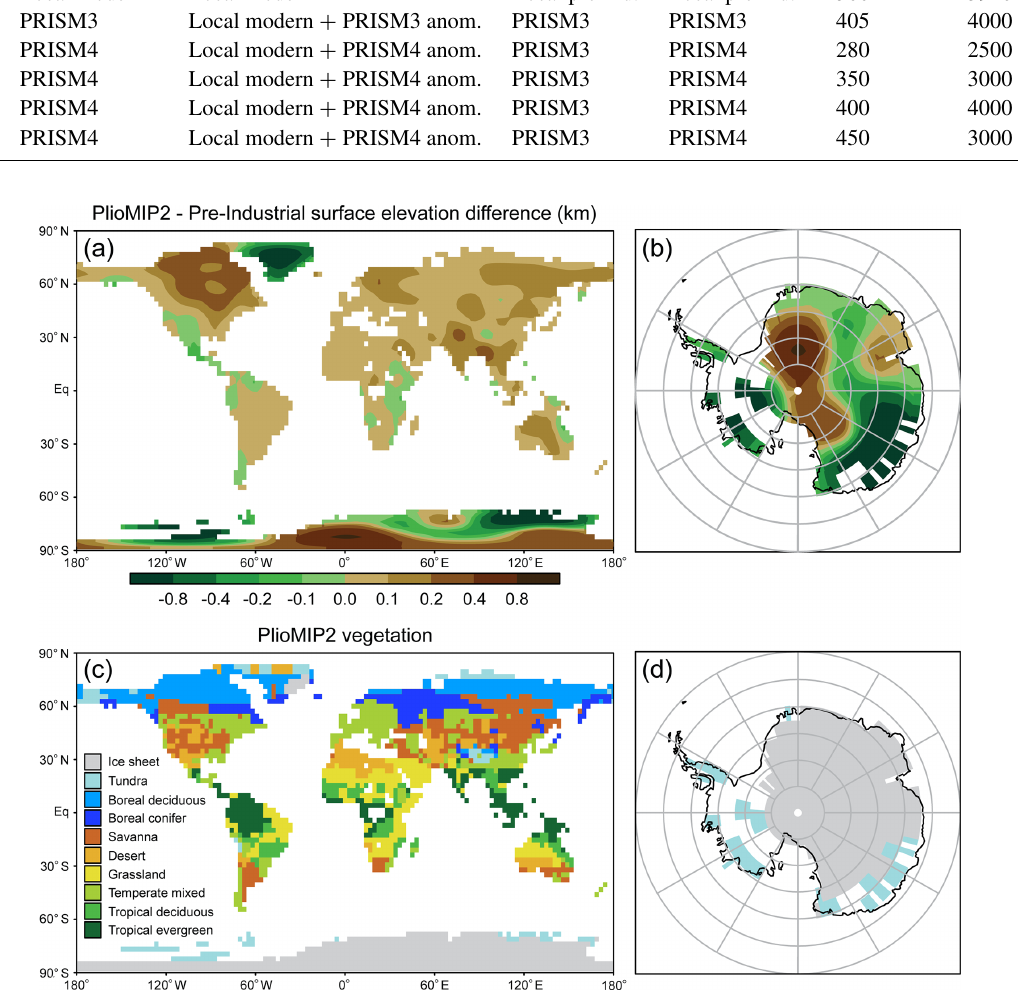
Figure 1. (a, b) The difference between land elevation in the Pliocene and present-day experiments and (c, d) the vegetation specified for Pliocene experiments on the MIROC4m